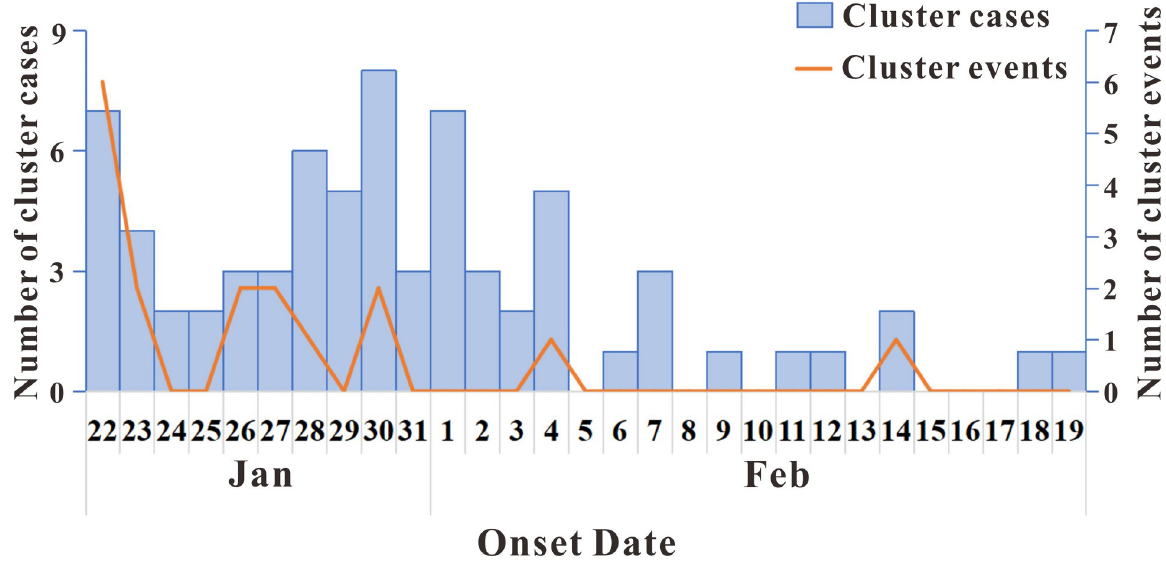
Fig 3. Onset time of cluster events and cluster